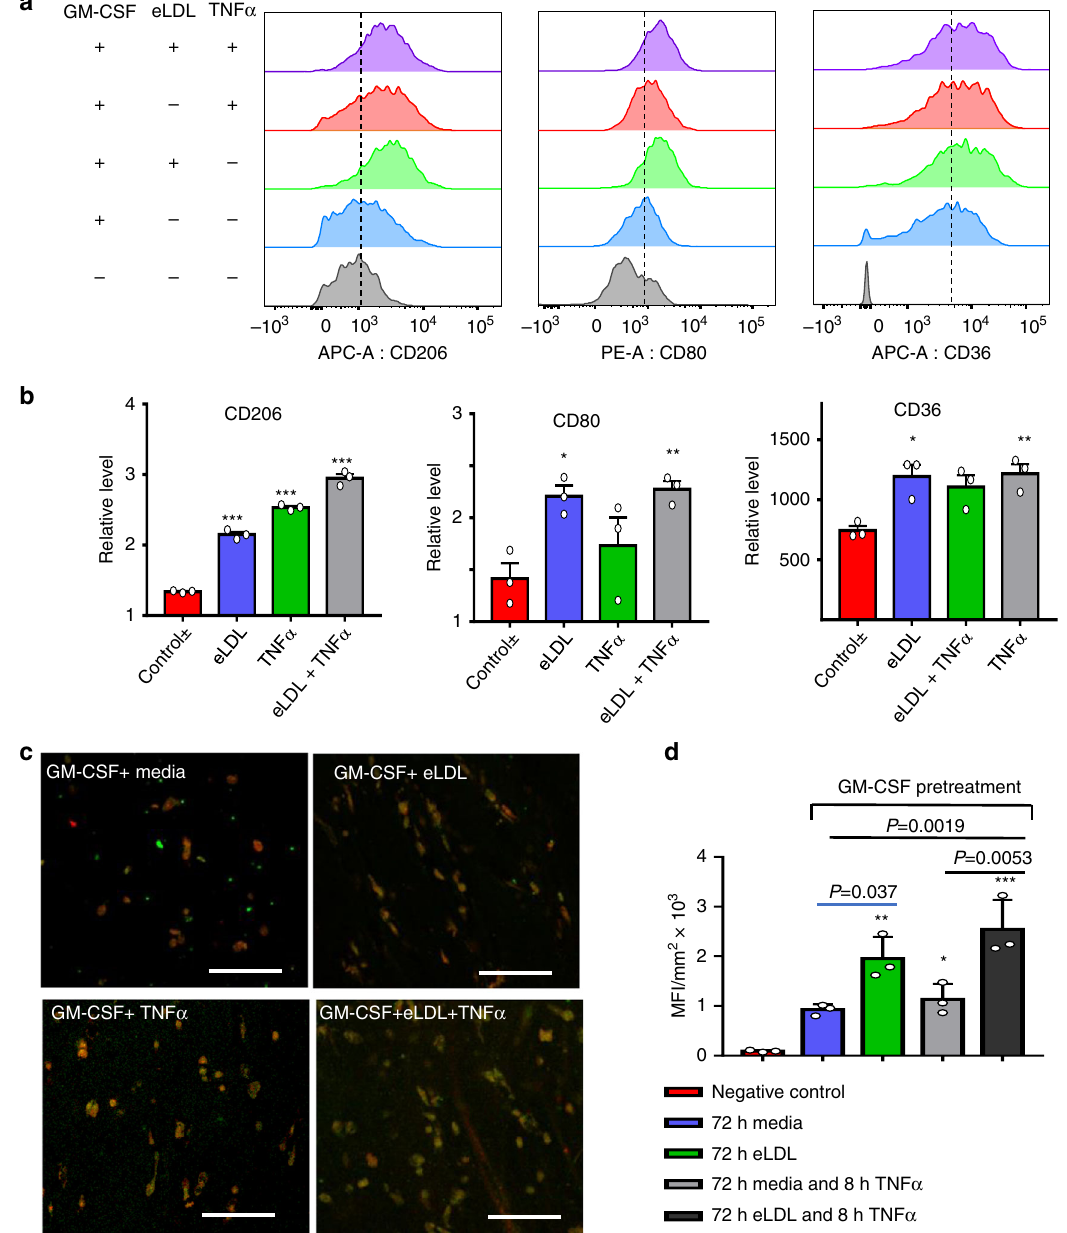
Fig. 7 Macrophage polarization in TEBVs after exposure to eLDL and/or TNF α . a Flow cytometry of primary human monocyte differentiation into macrophages with eLDL±TNF α treatment. b Quanti fi cation of the mean fl uorescence intensity (MFI) of fl ow cytometry results. The relative level represents normalization to negative control − / − (no GM-CSF/no treatments), (mean±S.D., n = 3 independent wells from two monocyte isolations, CD206: *** P < 0.0001; CD80: * P = 0.0397, ** P = 0.0267; CD36: * P = 0.0187, ** P = 0.0143, compared to control + / − = GM-CSF control/no treatments by one-way ANOVA and Tukey post hoc test). c Characterization of primary monocytes derived macrophages in perfused TEBVs with GM-CSF pretreatment and addition of eLDL for 96h with or without 8h TNF α treatment; fl uorescence images of, monocytes-cell tracker red, CD80 + monocytes-green (scale bar 100 μ m). d Quanti fi cation of mean fl uorescence intensity (MFI) per cell of CD80 + monocytes (green signal) based on the images in panel ( c ) (mean±S.D., n = 3 TEBVs, * P = 0.034, ** P = 0.00066, *** P <0.0001 compared to negative control by one-way ANOVA and Tukey post hoc